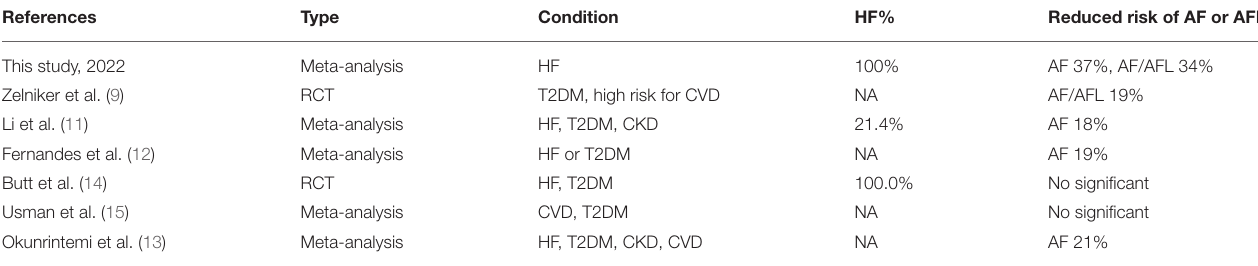
TABLE 2 | Differences between our study and other previous